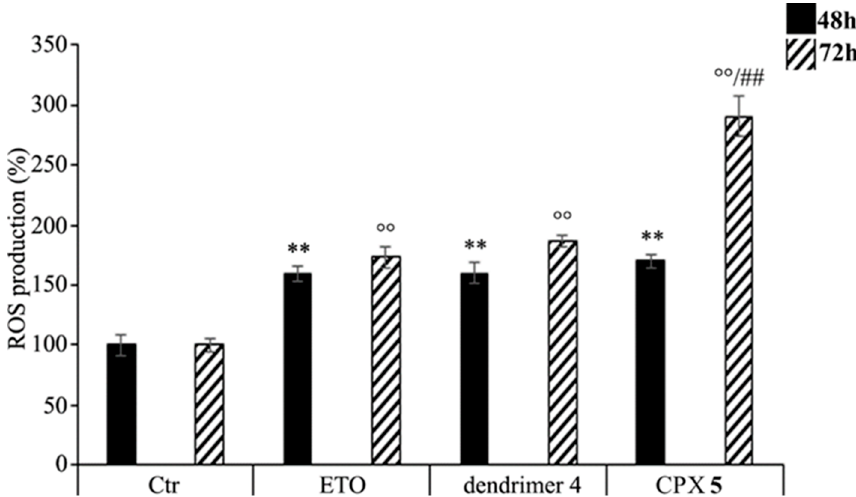
Figure 8. Reactive oxygen species (ROS) generation was analyzed in neuroblastoma (NB) cells exposed to ETO (1.25 µ M), CPX 5 (in a dose able of providing 1.25 µ M ETO), and dendrimer 4 (at the same dose of CPX 5 ) for 48 and 72 h. Histograms summarize quantitative data of the means ± SEM. of three independent experiments. ** p < 0.01 vs. Ctr cells (48 h); ◦◦ p < 0.01 vs. Ctr cells (72 h); ## p < 0.01 vs. ETO-treated cells (72 h).